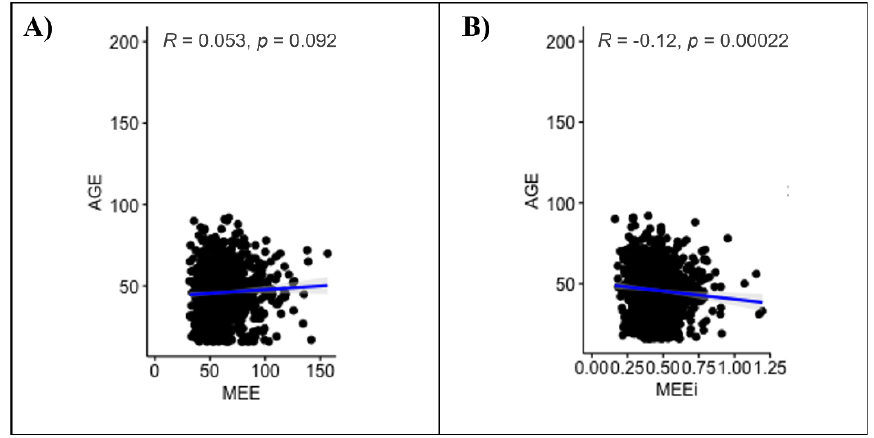
Figure 2. Univariate analysis of MEE ( A ) and MEEi ( B ) values by age. Table 4. MEE and MEEI values stratified by age in the study population.